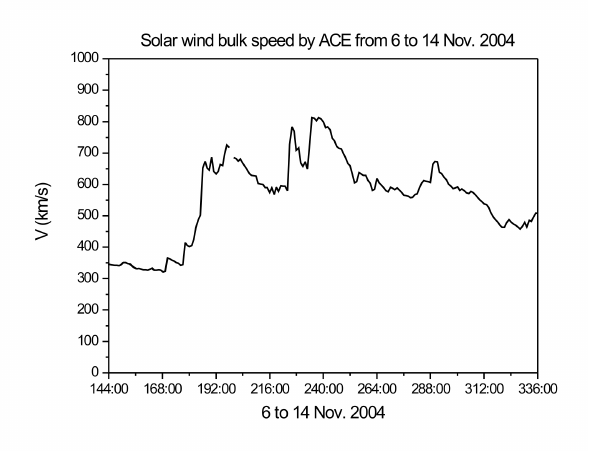
Fig. 17. Solar wind bulk speed recorded aboard the ACE spacecraft from 6–14 November